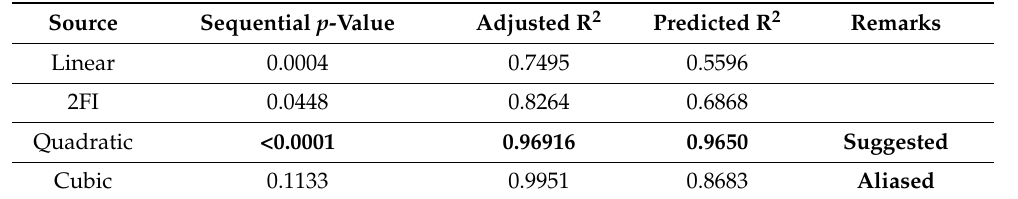
Figure 3. 3D power response of the tile.